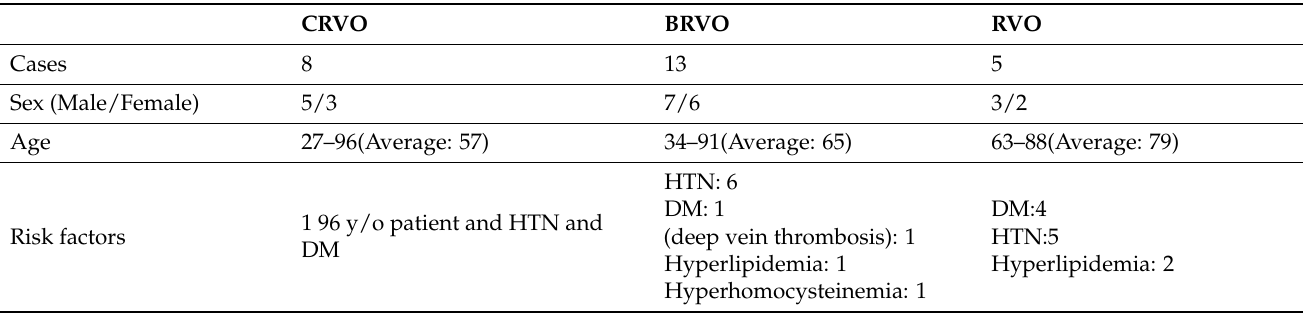
Table 4. Twenty-six cases of RVO after BNT162b2 vaccination. CRVO BRVO